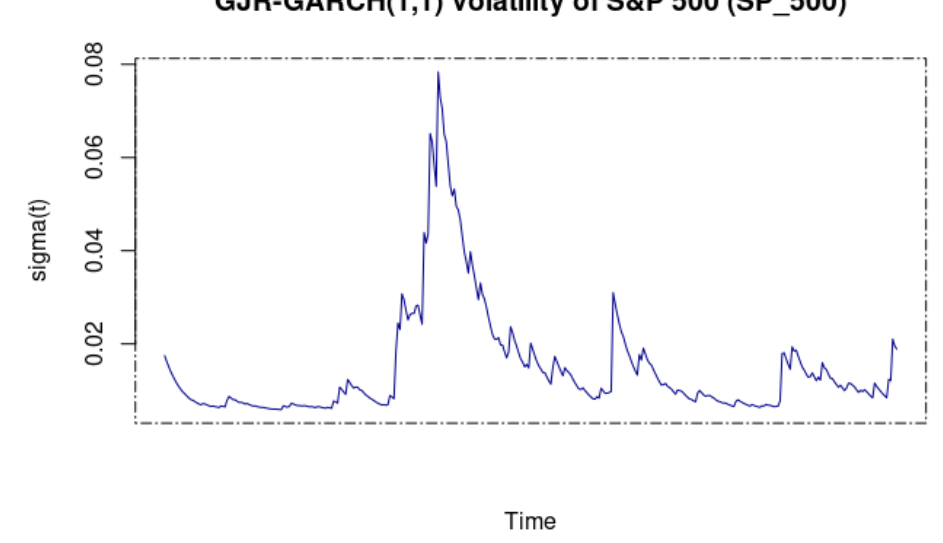
Figure 10. Volatility extracted from AR(1)-GJR-GARCH(1,1) model for S&P 500 (SP _ 500). FRED— Federal Reserve Bank of St. Louis.